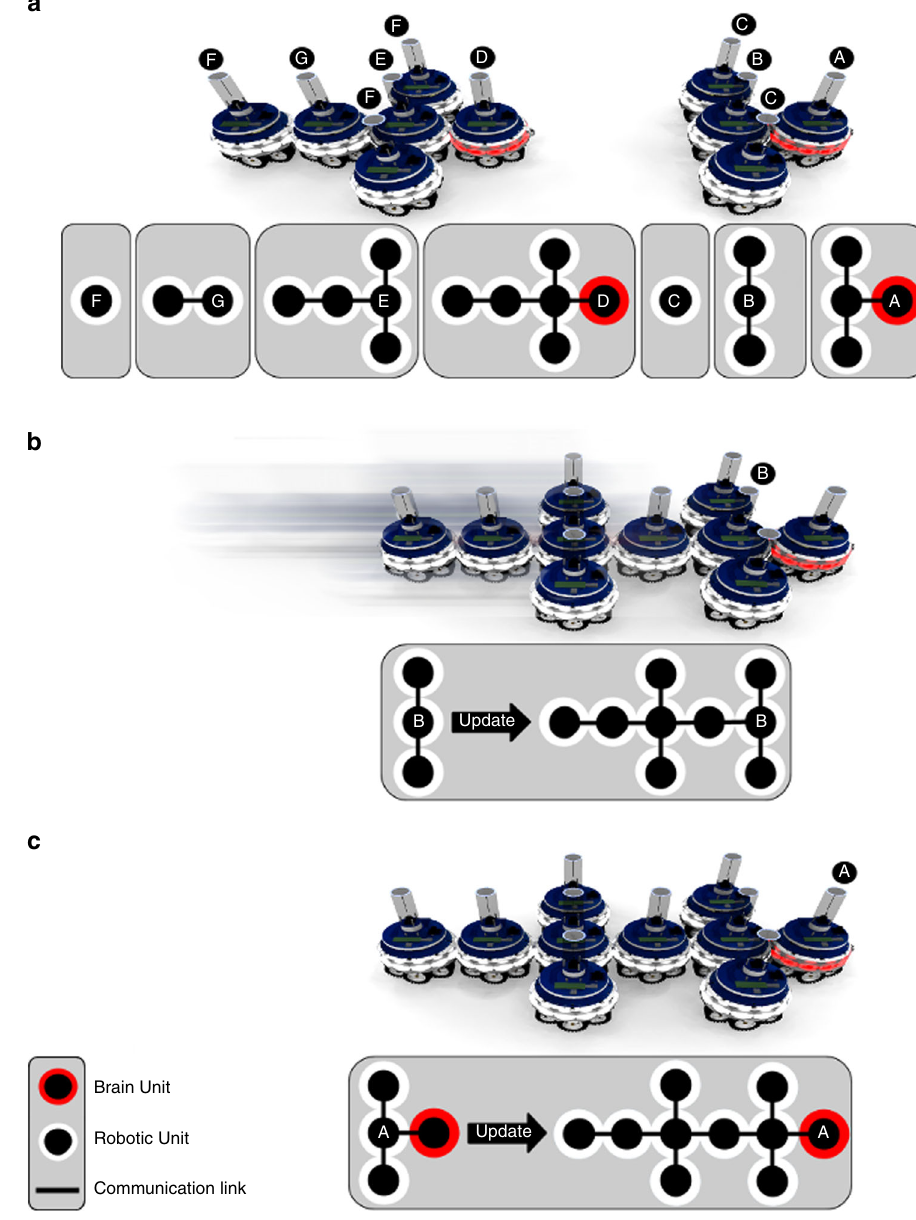
Fig. 3 Propagation of internal representation during the merging of two MNS robots. a The internal representations of robotic units are shown in the insets. In each of the insets, the robot whose internal representation is illustrated is indicated by the corresponding letter. Note that units that are not the brain unit only have awareness of their descendant units. b The robot on the left has assembled to the robot on the right . The brain unit of the robot that is attaching ( left robot) cedes authority to the brain unit of the robot to which it is attaching ( right robot). The brain unit of the new merged robot still does not have an accurate internal representation of its new morphology. However, its child robotic unit has already updated its internal representation. c Information about the morphology has propagated to the